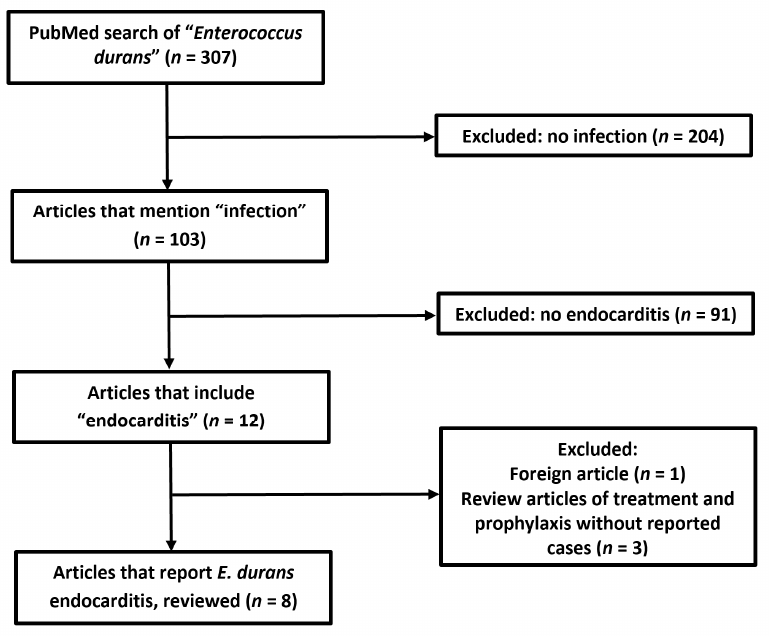
Figure 5. Flowchart of literature search according to Preferred Reporting Items for Systematic Reviews and Meta-Analyzes (PRISMA) guidelines. Table 1. Summary of published E. durans endocarditis case reports.